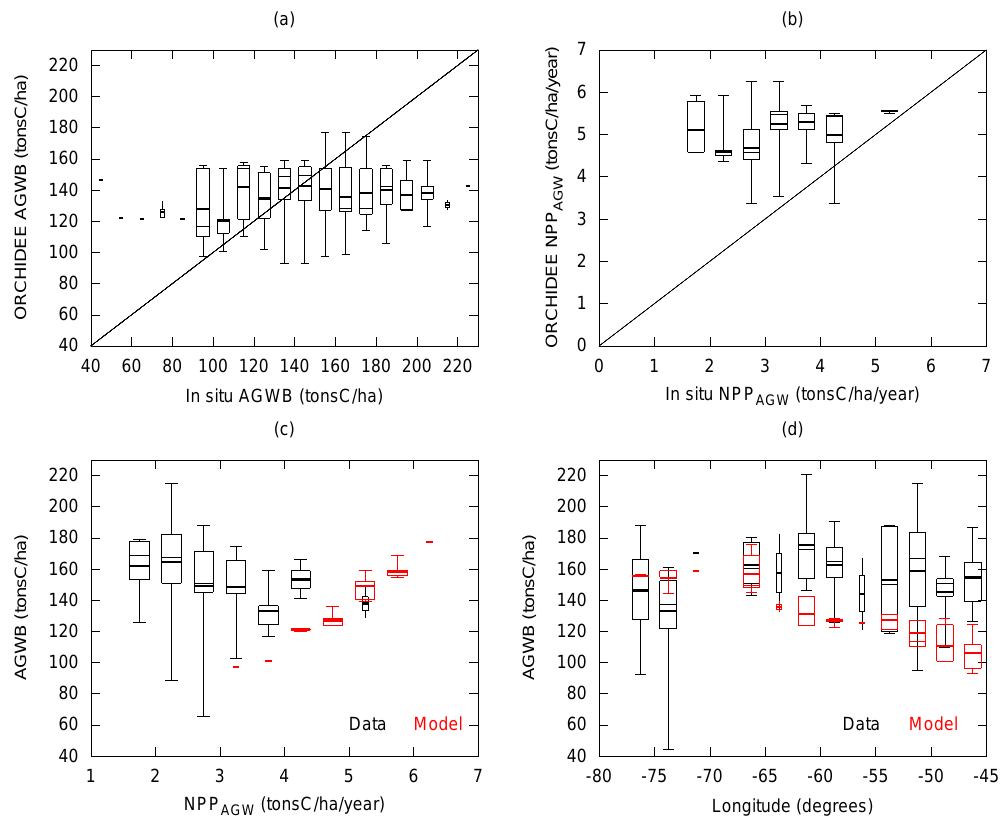
Fig. 2. Comparison of ORCHIDEE outputs with ground measurements. (a) Above ground woody biomass (AGWB); (b) Net Primary Pro- duction allocated to above ground wood (NPP AGW ). (c) AGWB against NPP AGW from ORCHIDEE and ground measurements. (d) AGWB against longitude for latitude between 2 ◦ north and 10 ◦ south, from ORCHIDEE and ground measurements. Ground measurements are from Malhi et al. (2004, 2006). For each x-axis class: the vertical box represents the 25 and 75 percentiles; median in represented by a light line; average is represented by a bold line; whiskers extremities show the minimum and maximum values. In (c) and (d), red is for ORCHIDEE outputs and black for the ground measurements. The width of the box is reduced by half if less than 5 sites belong to a specific x-axis